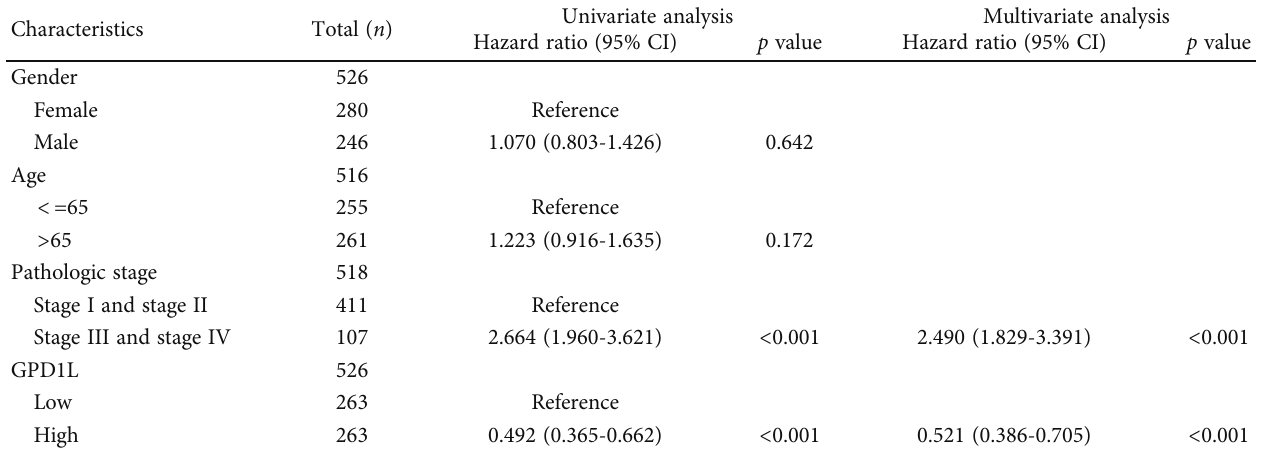
Table 2: Univariate and multivariate analysis of overall survival in LUAD patients.